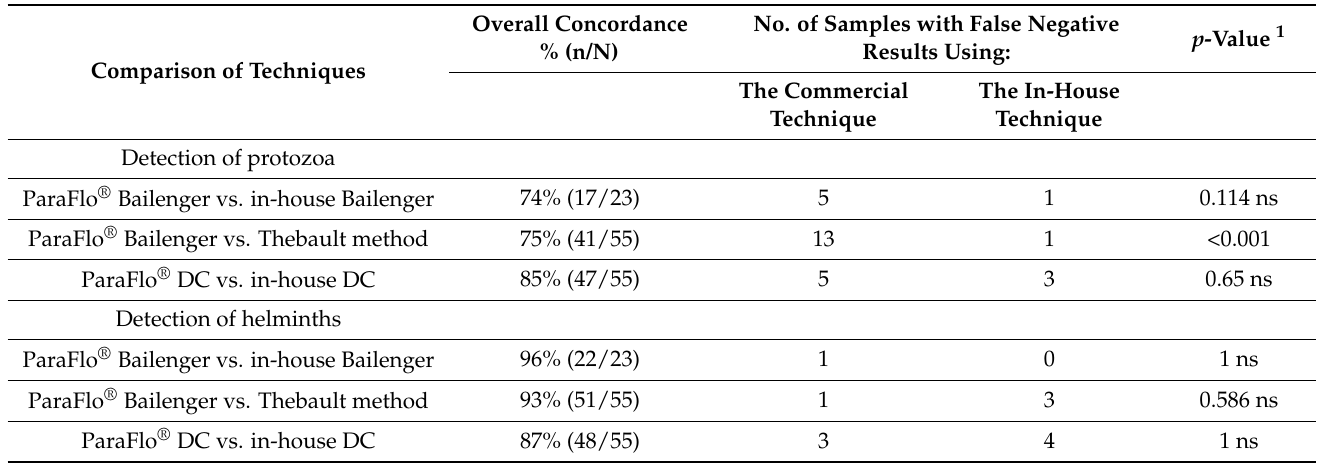
Table 3. Separate analysis of the performances of commercial techniques compared to routine procedures for the detection of protozoa and